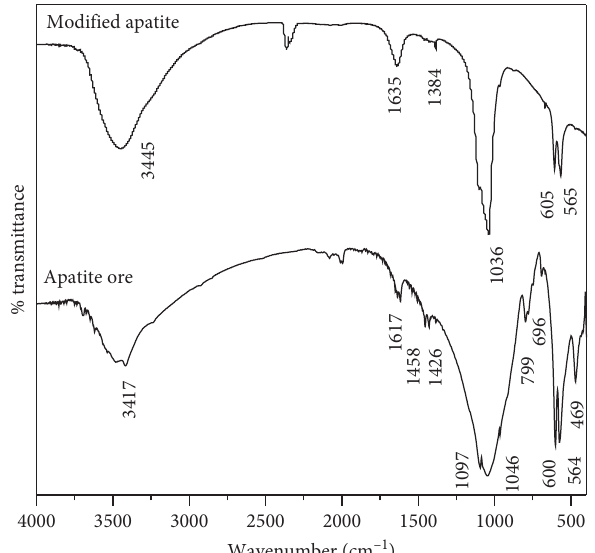
Figure 1: FT-IR spectra of apatite ore before (a) and after (b)